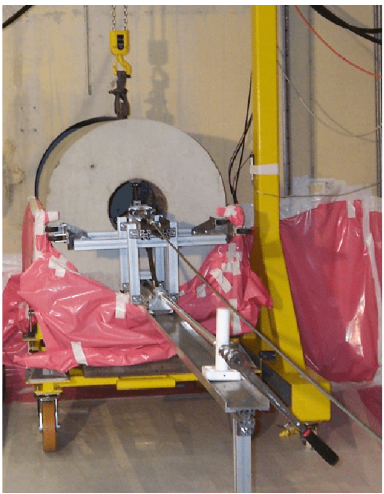
FIG. 19. Extraction of one of the original shielding blocks onto the support cradle.